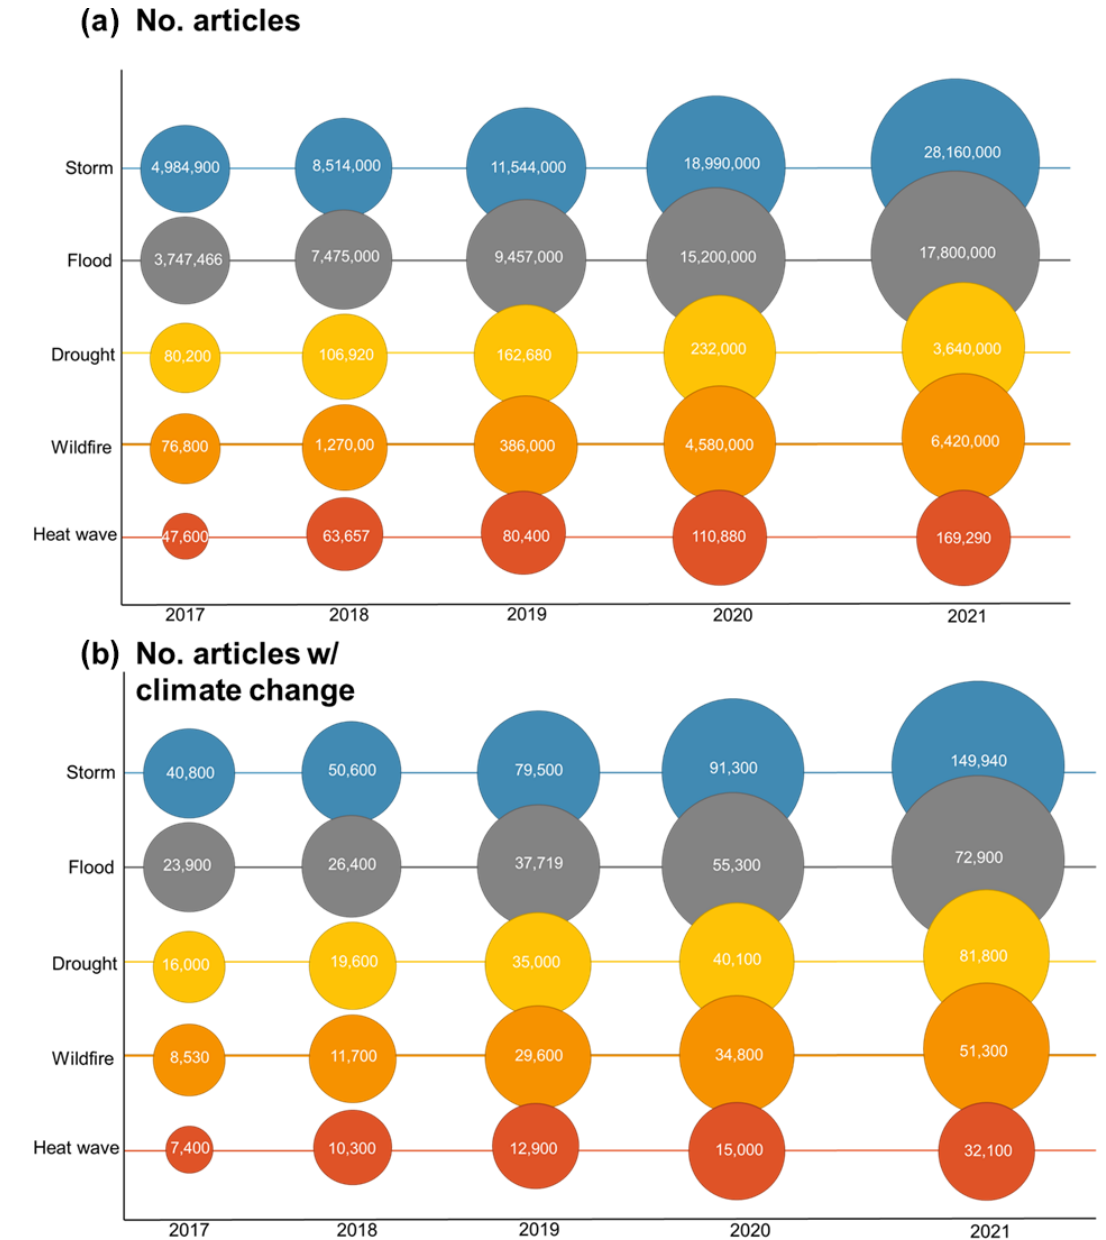
Figure 2. Number of articles per hazard per year for 2017 to 2022; (a) indicates overall article numbers, while (b) indicates only articles that contain weather hazards and climate change as their